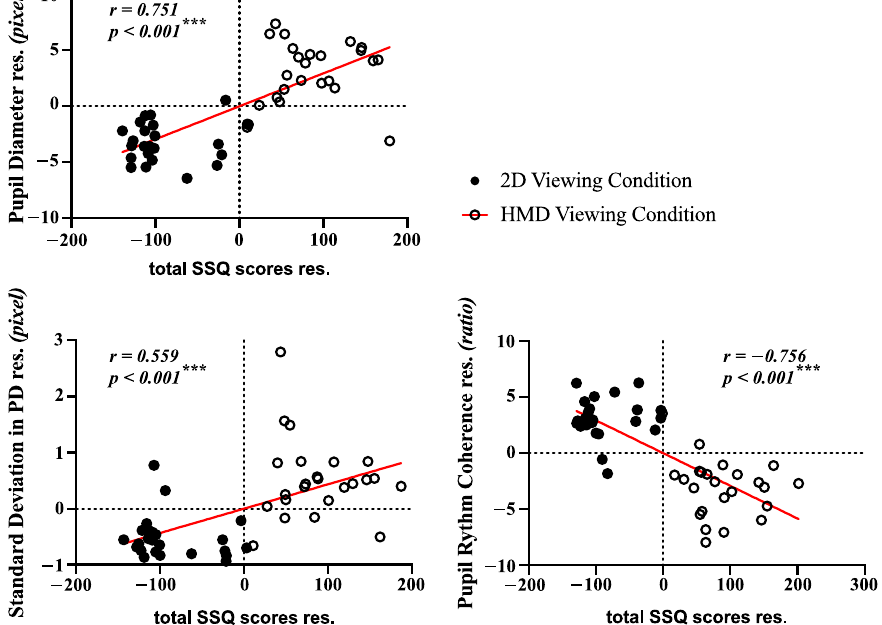
Figure 8. Results of the correlation analysis between SSQ scores and significant features of pupillary rhythms.